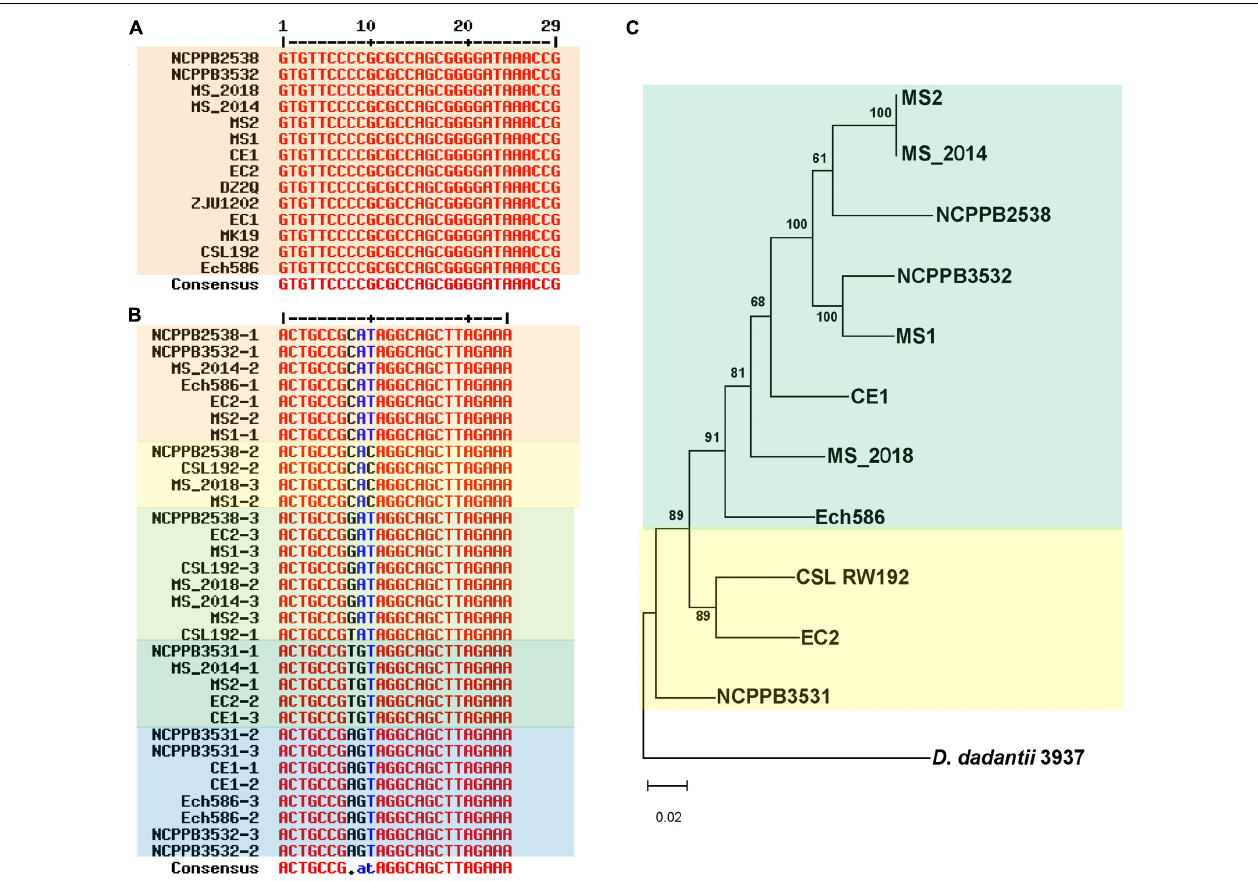
FIGURE 6 | Genomic differentiation of D . zeae strains at clustered regularly interspaced short palindromic repeat (CRISPR) arrays. (A) Alignment of direct repeat (DR) sequences of type I-E CRISPR arrays. Strain NCPPB 3531 lost this array. (B) Alignment of DR sequences of type I–F CRISPR arrays. (C) Phylogenetic dendrogram based on genomic sequences of type I–F CRISPR arrays with the maximum likelihood method bootstrapped at 1,000 replications, D . dadantii 3937 was used as an out-group